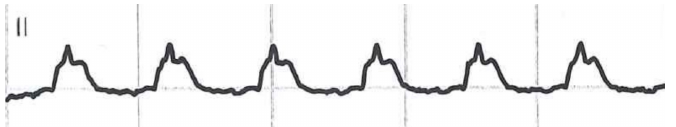
Image 1. Electrocardiographic (lead II) taken from the Monitor System demonstrating the “spiked helmet” sign.